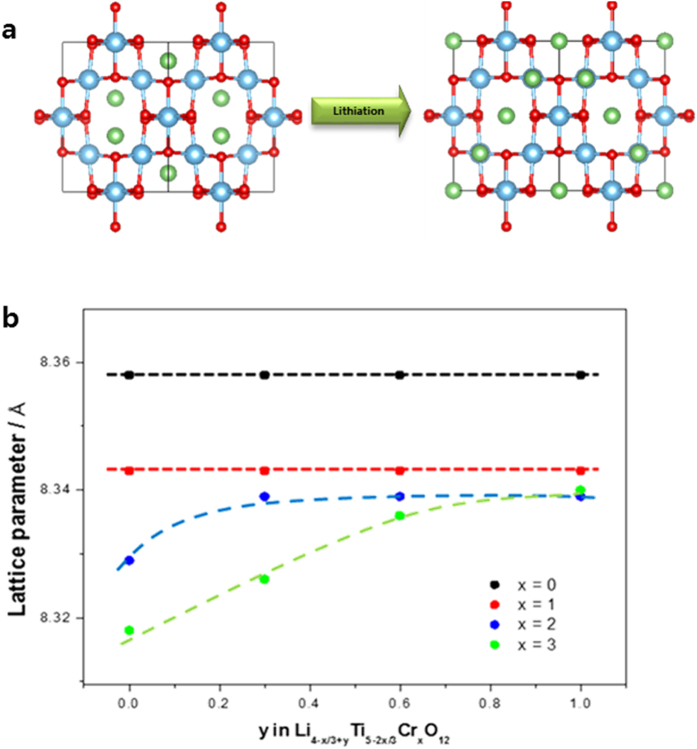
(a) Lattice structural changes of Li4Ti5O12 anode materials during lithiation showing the zero-strain characteristic of them. (b) Changes in the lattice dimension of Li4−x/3+yTi5−2x/3CrxO12 as a function of y.